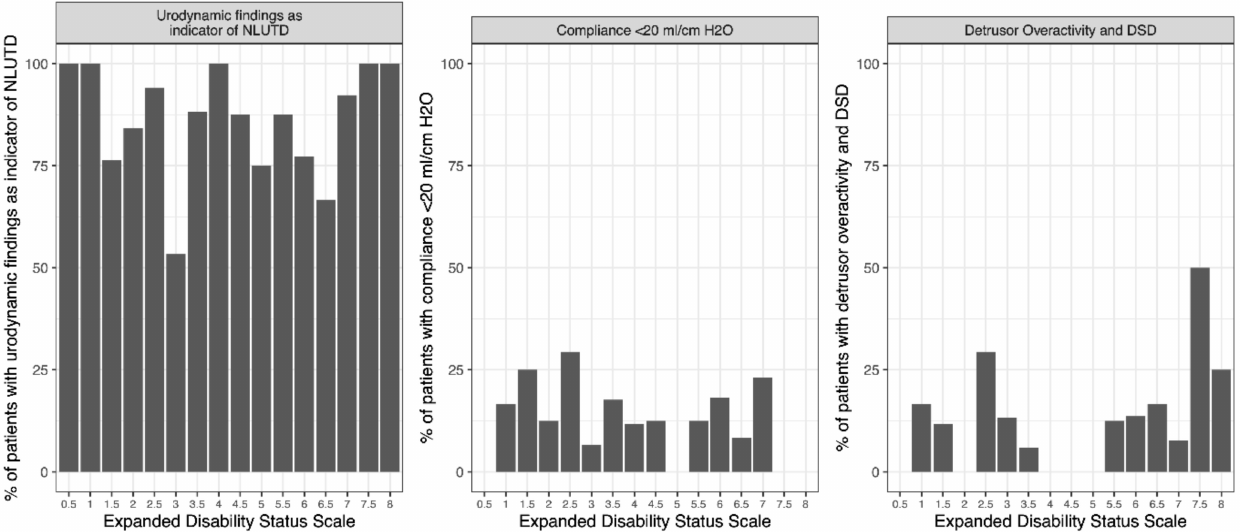
Figure 1. Analysis of Expanded Disability Status Scale threshold. NLUTD, neurogenic lower urinary tract dysfunction; DSD, detrusor sphincter dyssynergia.